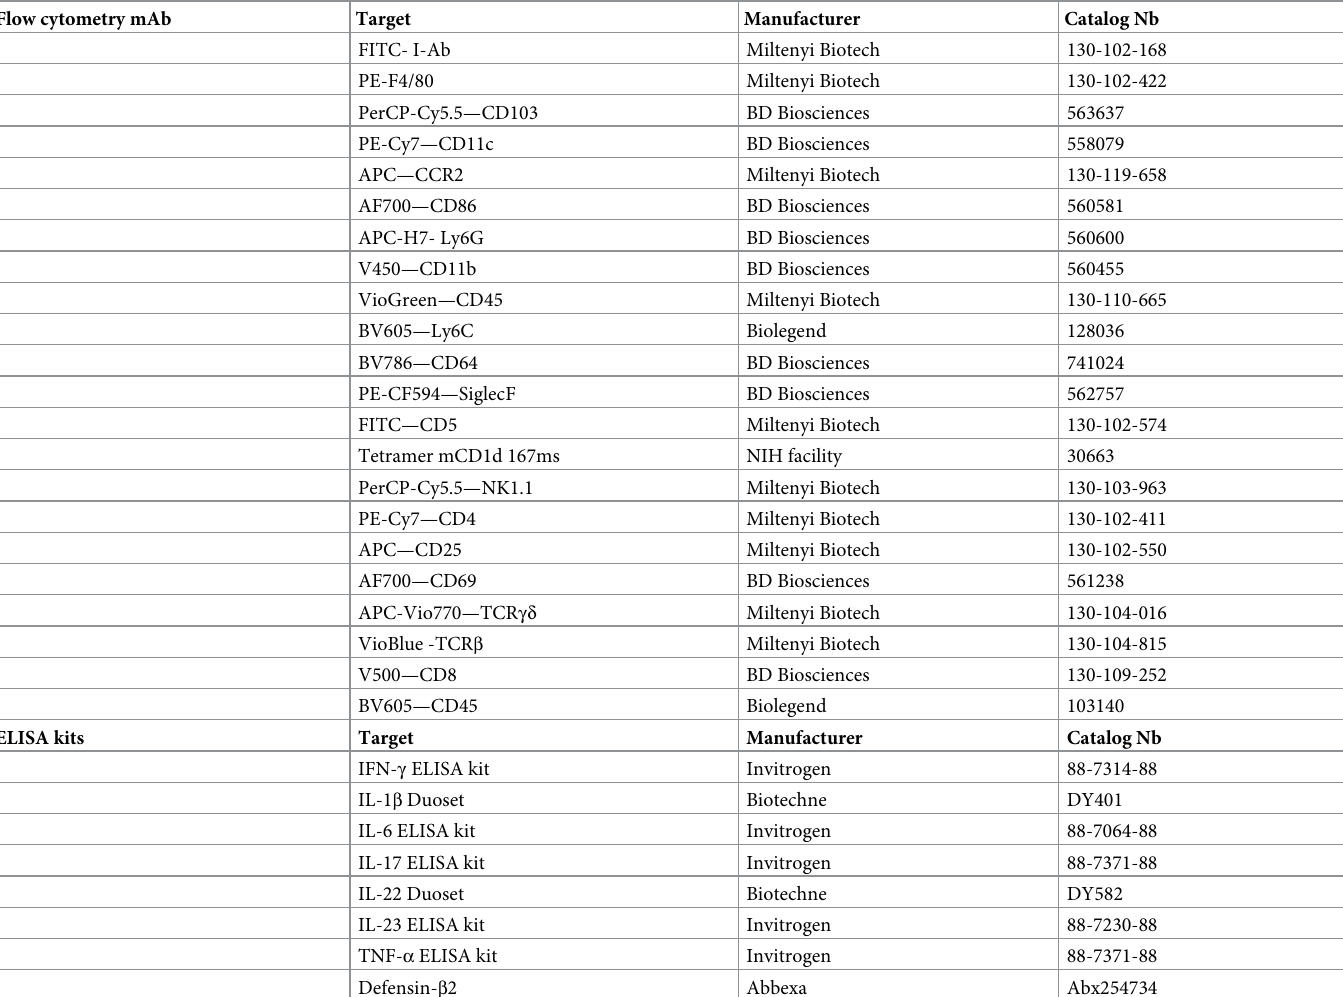
Table 2. List of the antibodies and of the ELISA kits used in this study. Flow cytometry mAb